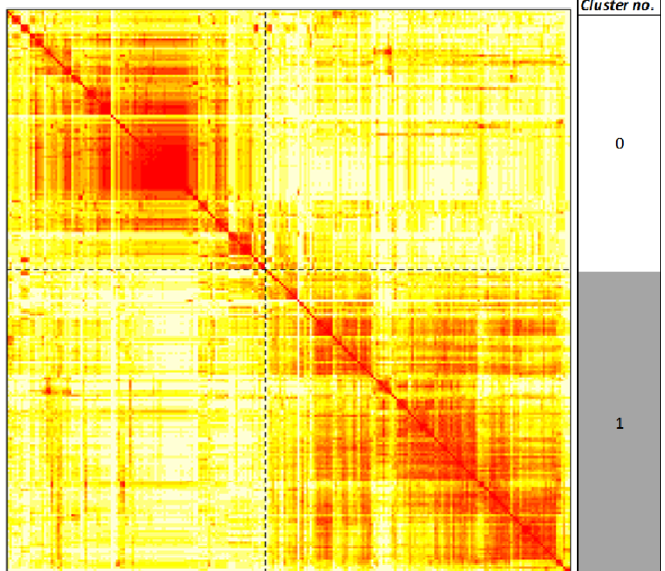
Figure 2. Unsupervised clustering of KEGG human pathways targeted by 29 leukemogens and 11 non-leukemogenic carcinogens. The 250 pathways are clustered based on the distance between the columns (corresponding to the pathways) of the matrix of transformed pathway enrichment p values over all the 40 chemicals (corresponding to the rows). The figure is a visual representation of the distance matrix between all the chosen pathways. The color of the (i,j)th position of the distance matrix, where i and j represent indices in the set of human pathways indexed by values in the set {1, 2,…250}, is a measure of how close pathway i and pathway j are to each other based on the enrichment of their gene targets on all the 40 chemicals. The color ranges from white to red, with red indicating greater closeness of a pair of pathways. Dashed black lines indicate boundaries of clusters of pathways as determined by the Hierarchical Ordered Partitioning